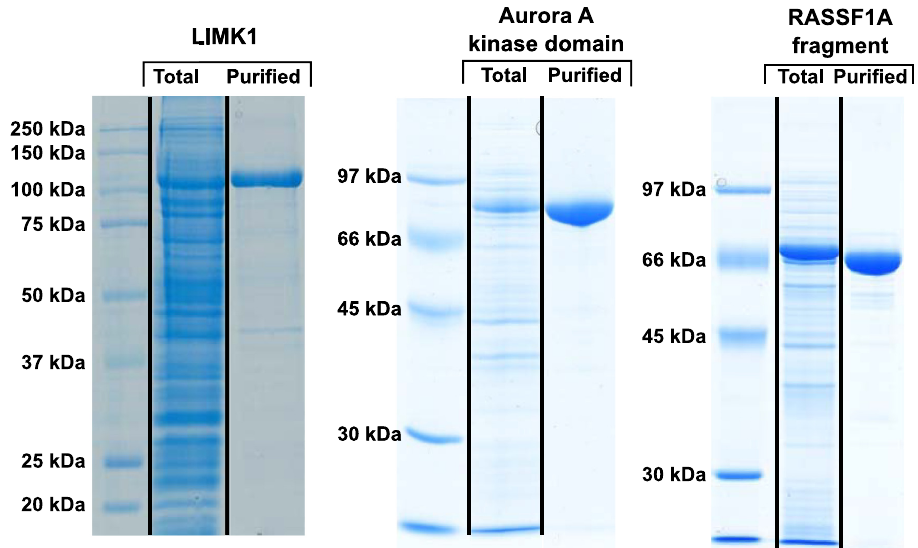
Fig 5. Purity of various protein constructs expressed using pONE vectors. The pONE vector set was also applied to express the following proteins. Full-length LIMK1 (M w ~117 kDa) was expressed in the insect cells S . frugiperda , using the vector pONE-30A. The kinase domain of Aurora kinase A (M w ~79 kDa) as well as a RASSF1A fragment (residues 121–340, M w ~70 kDa) were both expressed in the bacterium E . coli using pONE-10K. All molecular masses correspond to the recombinant proteins in fusion with an MBP tag. Samples were taken before harvesting the cells (‘Total’) and from the final, purified protein product (‘Purified’). The samples were analysed by SDS-PAGE and subsequent staining by Coomassie brilliant blue. All proteins were expressed in substantial quantities (Table 3), and could be purified. Using pONE vectors, pure recombinant proteins (LIMK1, Aurora A kinase domain and a RASSF1A fragment) were obtained with high yield.